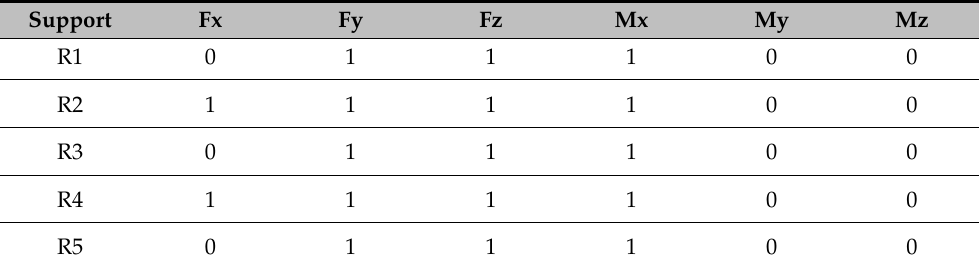
Table 8. Main modal frequencies and participating masses obtained by the nominal